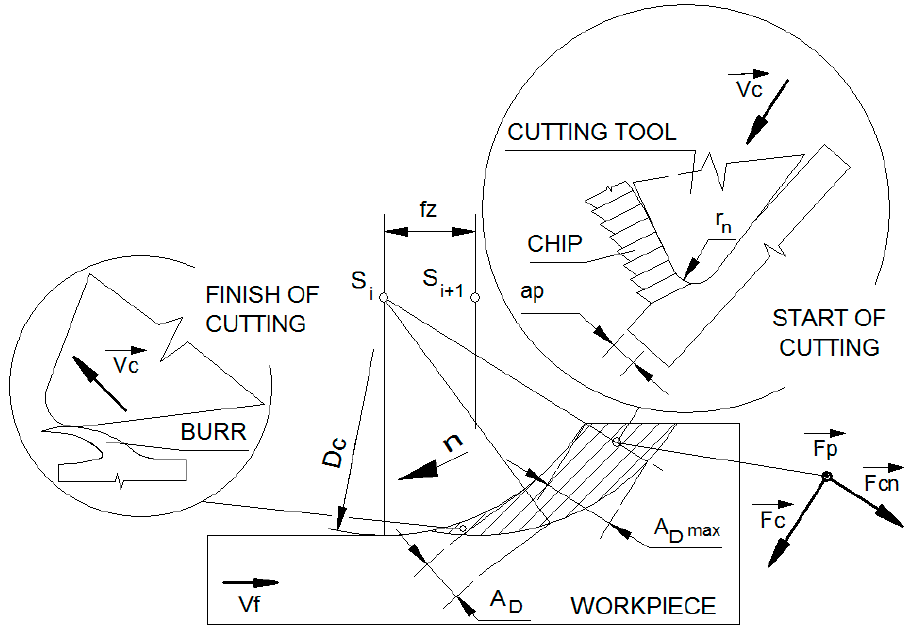
Figure 17. Burr production at the down ‐ milled UHMWPE surface—due to kinematics of cutting and visco ‐ plasticity of the material, not all cut material is converted to a chip and removed. Legend: v c —cutting speed, v f —feed speed, a p —depth of cut, D—diameter of the milling cutter, n—rotation of the cutter, f z —feed per tooth, A D —chip cross ‐ section, S i —position of milling cutter centre, Fc—cutting force, Fcn—perpendicular cutting force, Fp—passive force.